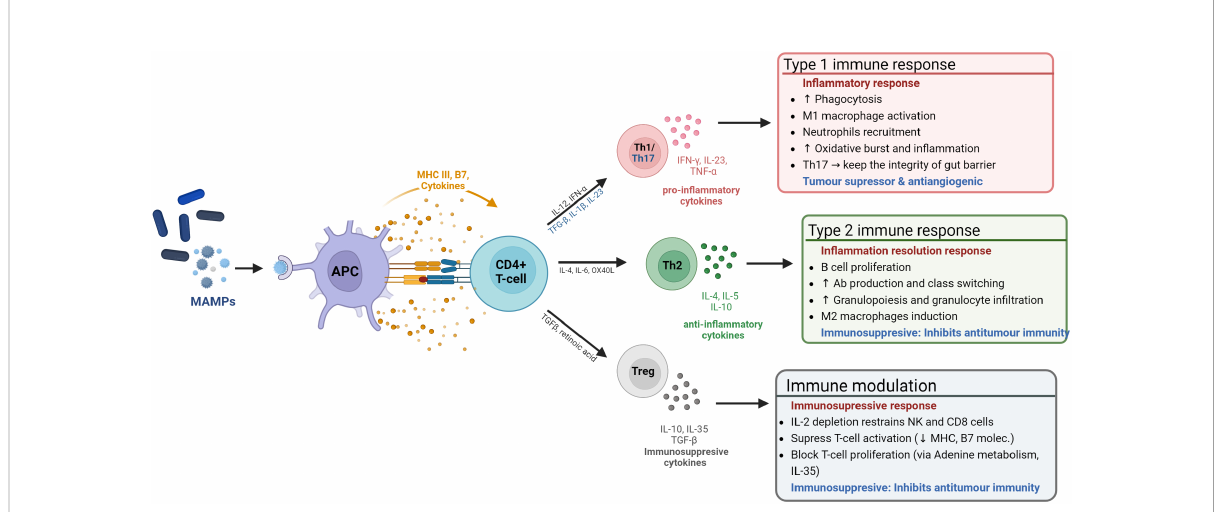
FIGURE 2 The microbiome in fl uence on the host immune system. The microbiome modulates the immune system through MAMP production. These are sensed by antigen presenting cells (APCs), which process them to be presented to CD4+ naïve T-cells to induce either immune tolerance or an immune